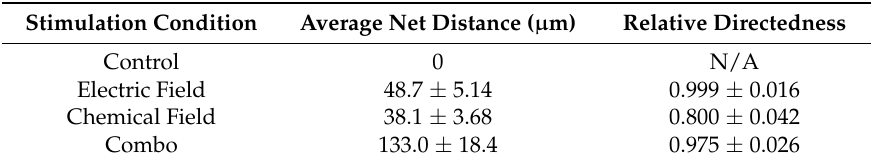
Figure 7. Galvano-, Chemo-, and Galvano-Chemo-Induced migration of RPCs. ( A ) Distance traveled within Gal-MµS device for electrical, chemical, and combinatory stimuli. ( B ) Representative cell trajectories for electrical, chemical, and combinatory stimuli. Trajectories represent 12 h of cell movement within the device. Table 3. Average Retinal progenitor Cells (RPC) Migration Statistics for Various Stimulation